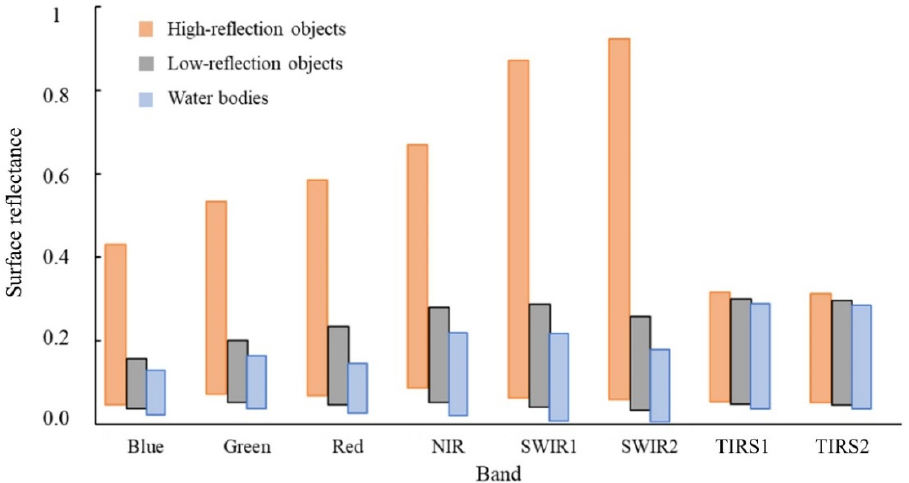
Figure 12. Value distribution of sample points of high-reflection ground objects, shadows of buildings, and water bodies in Landsat ‐ 8 surface reflectance data.